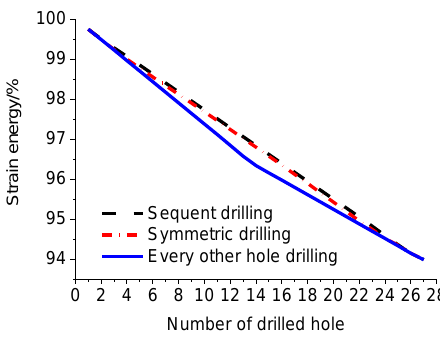
Figure 21. Deformation varying with amount of drilling. Table 4. Variations in deformation and strain energy with different drilling processes. Every Other Hole Drilling Process No.